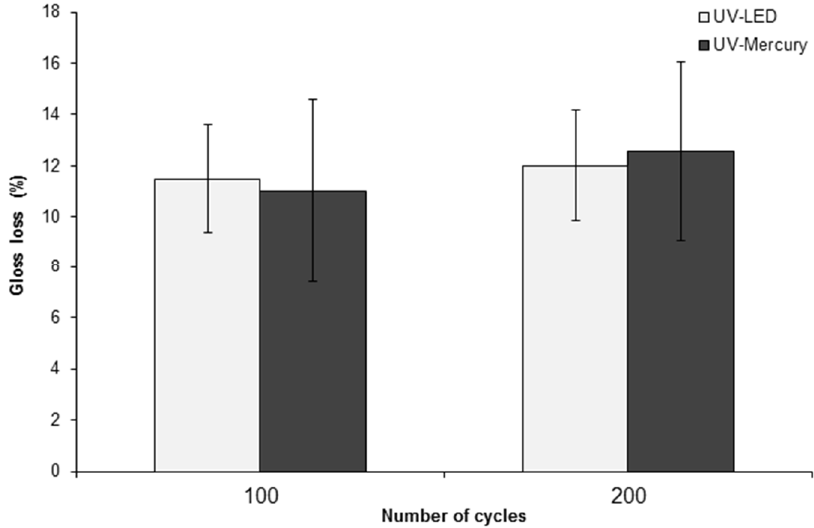
Figure 3. Gloss loss of the cured samples with UV-LED and UV-mercury lamp in function of the number of